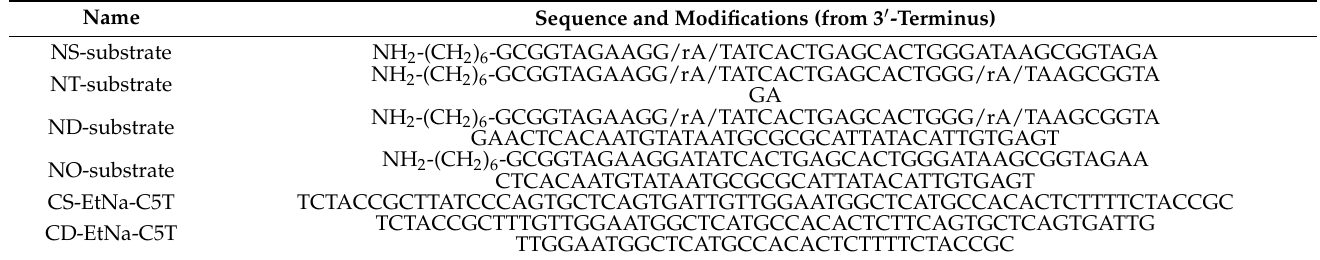
Figure 2. ( A ) CP-functionalized superhydrophobic solution with incubation time in the range of 2 min to 30 min.; ( B ) resistance change in SPFET/SWNTs-PCA with different volume of semiconducting ink at V DS = − 0.1 V, V G = 0 V; ( C ) relative resistances changing with the structure and length of DNAzyme for three different Ca 2+ concentrations. Each data point is an average of measurements from 3 independent biosensors. Table 1. DNA oligonucleotides in this